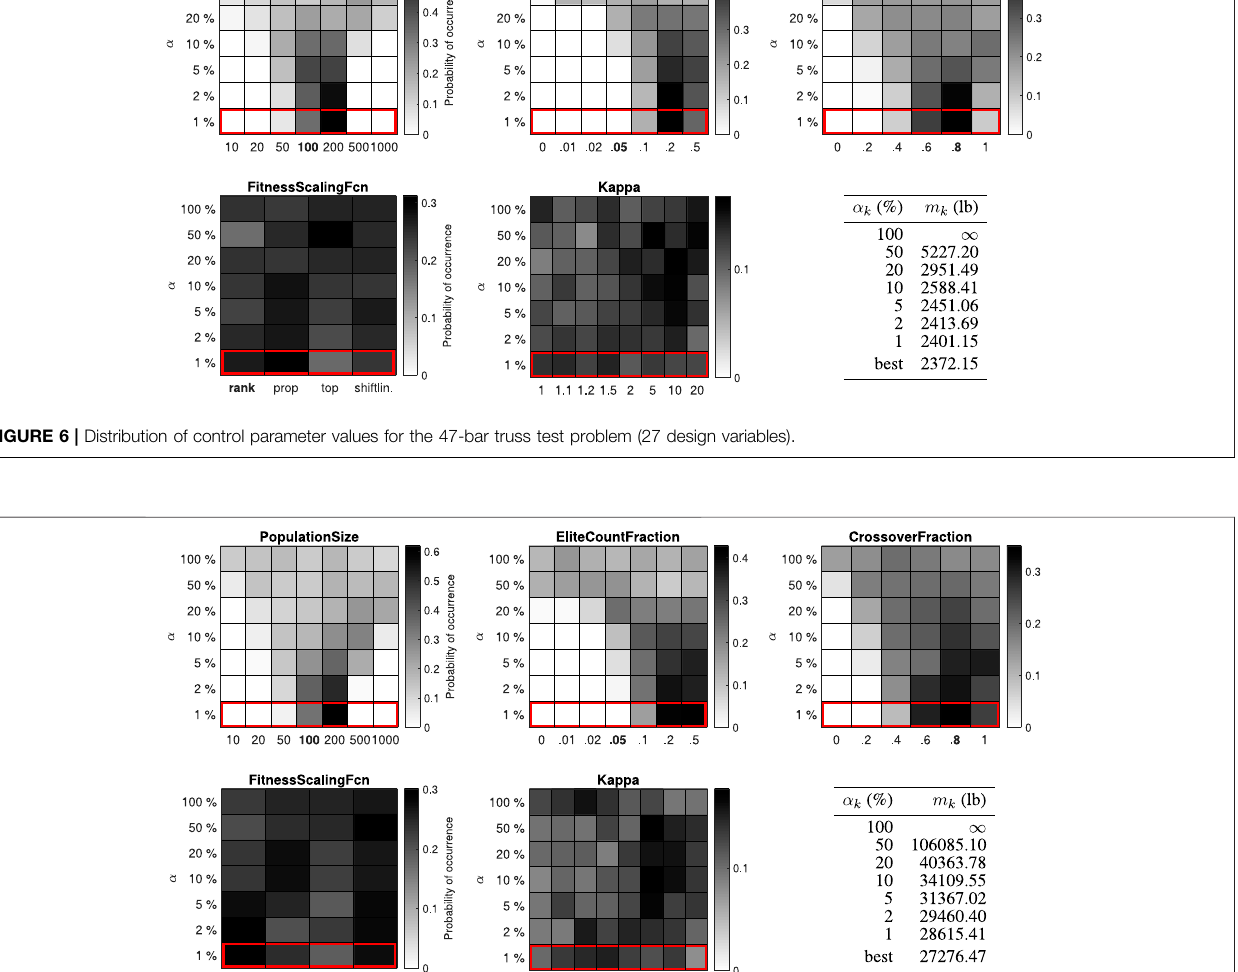
Frontiers in Built Environment |